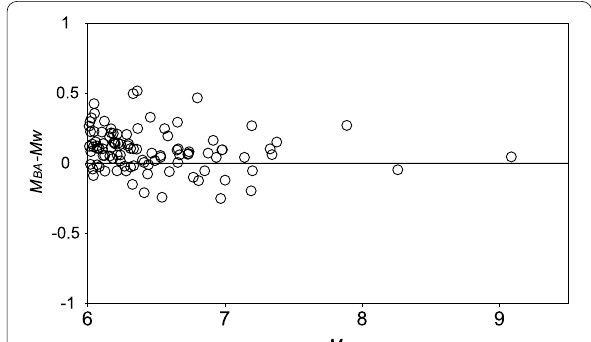
Fig. 7 Comparison of magnitudes estimated from the multiband amplitude distribution ( M BA ) with M w for events around